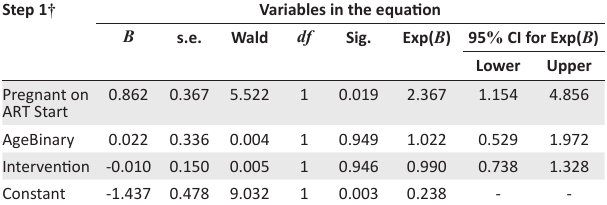
TABLE 5: Multivariable analysis of factors associated with virologic